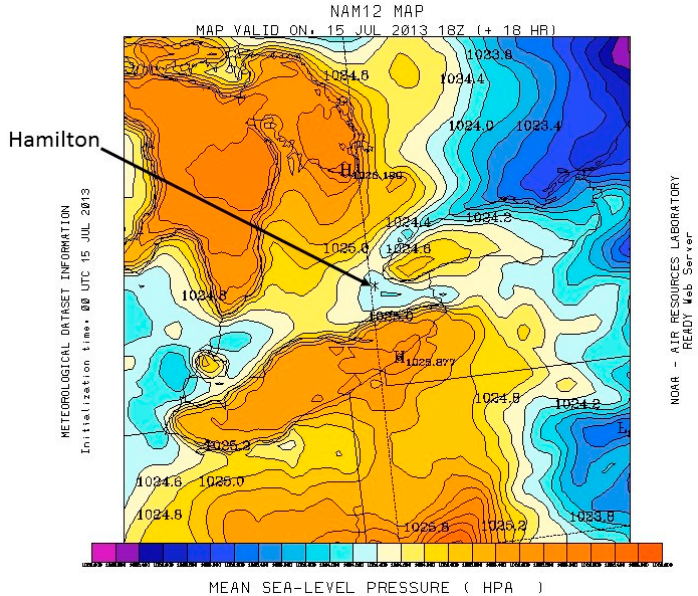
Figure 17. MSLP (shown at 0.2 hPa intervals), 15 July 2013, EDT 14:00, with the arrow marking Hamilton, Ontario. Credit: NOAA ARL.